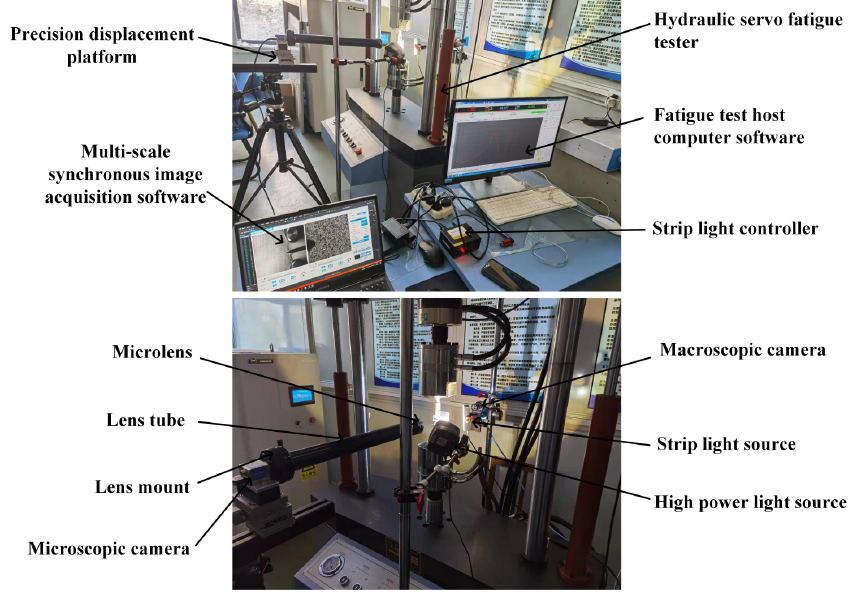
Figure 4. Experimental set-up [29].